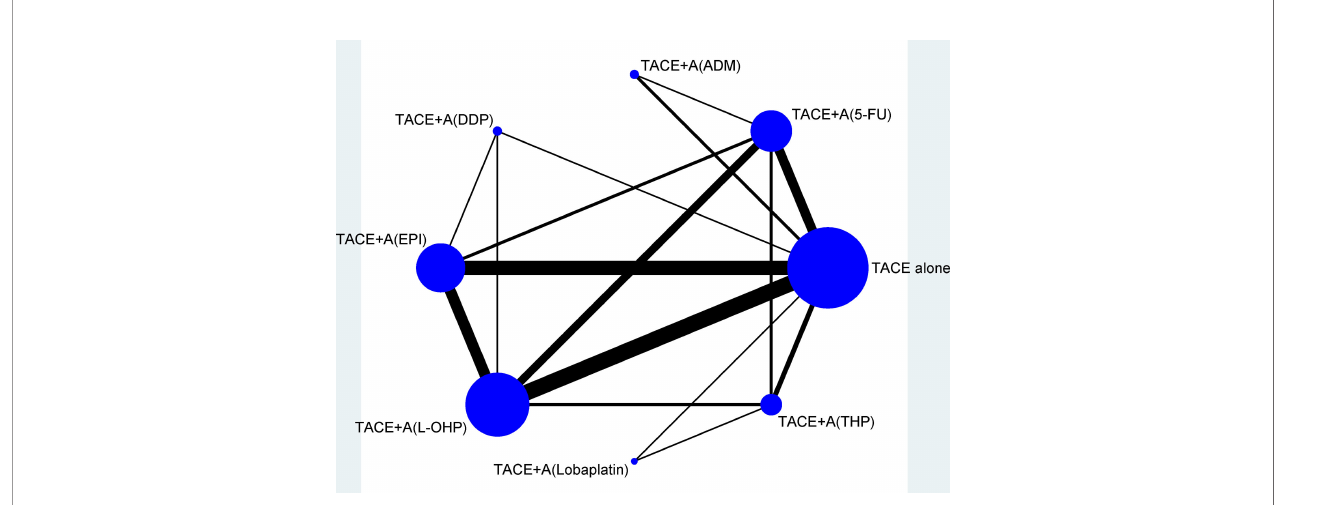
FIGURE 2 | Network of eligible ef fi cacy comparisons of TACE + apatinib versus TACE in treatment response. The width of the lines is proportional to the number of studies comparing every pair of direct comparisons of treatment agents in TACE, and the size of each node is proportional to the number of treatment participants.